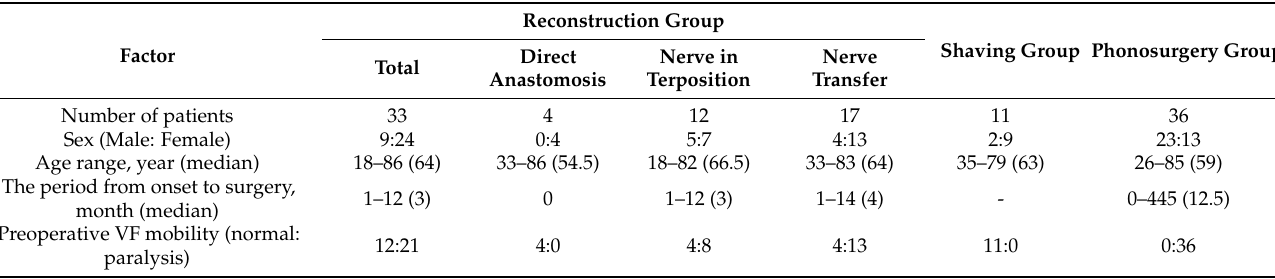
Table 1. Patients’